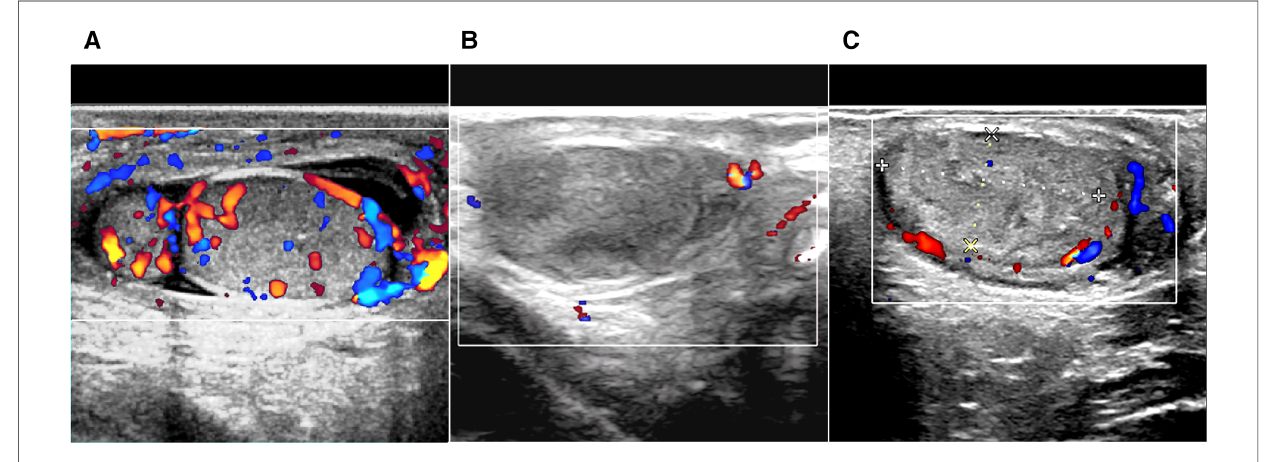
FIGURE 1 Ultrasound scan of immunoglobulin A vasculitis with testicular/epididymal involvement. ( A ) Enlarged epididymis, fl uid retention in the scrotum, and increased blood fl ow in the testis are shown on color Doppler. ( B,C ) The testis has hyperechoic and heterogeneous echoic areas, and the intratesticular blood fl ow is absent ( B ) or decreased ( C